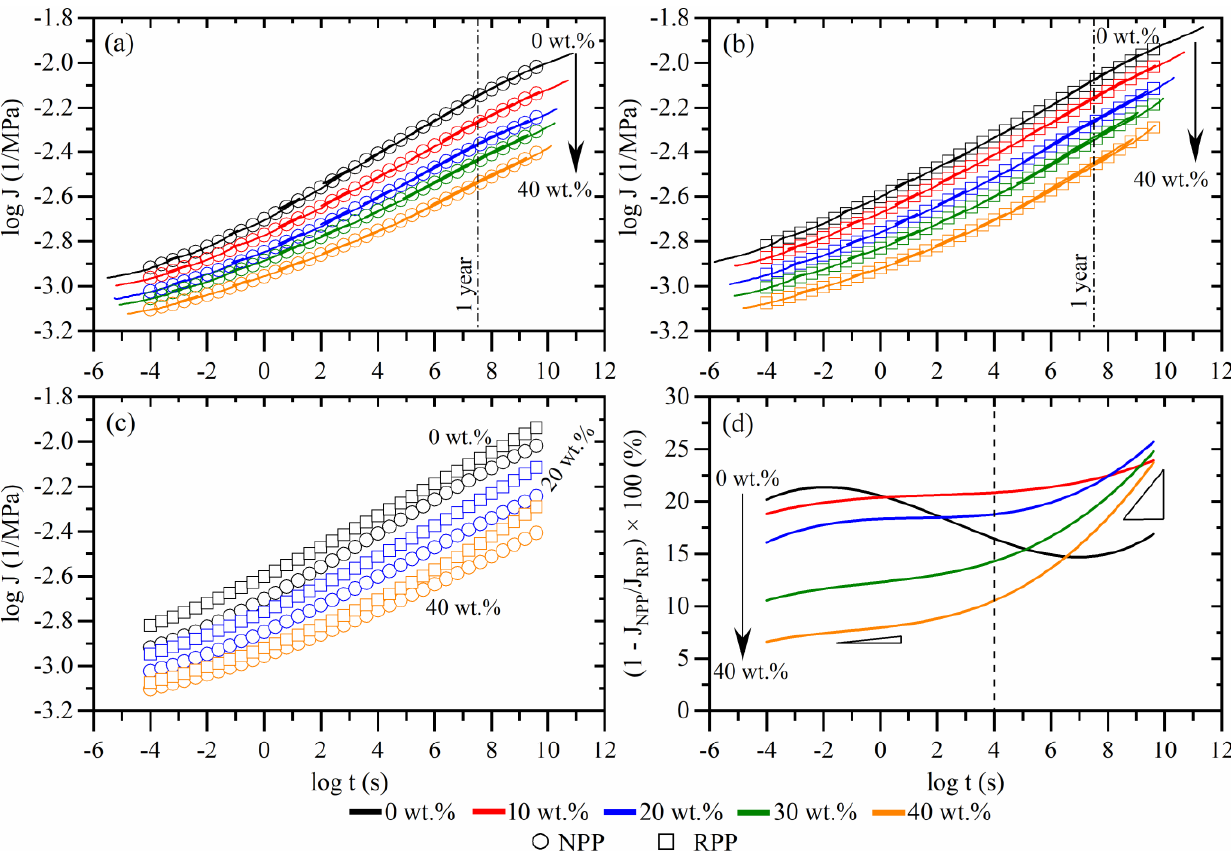
Figure 2. Shear creep compliance mastercurves at T ref = 20 ◦ C of composites with neat (NPP) matrix ( a ) and recycled (RPP) matrix ( b ); ( c ) comparison of creep with NPP and RPP matrix at selected wood fiber concentrations; ( d ) relative difference of creep compliance between composites with NPP and RPP matrix.